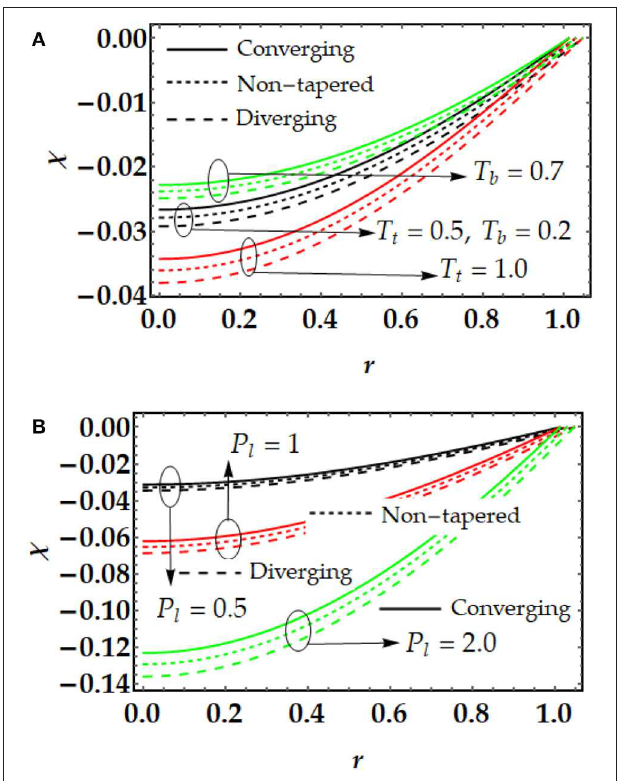
FIGURE 5 | Motile microorganism curves for multiple values of (A) T t and T b , (B) P l .